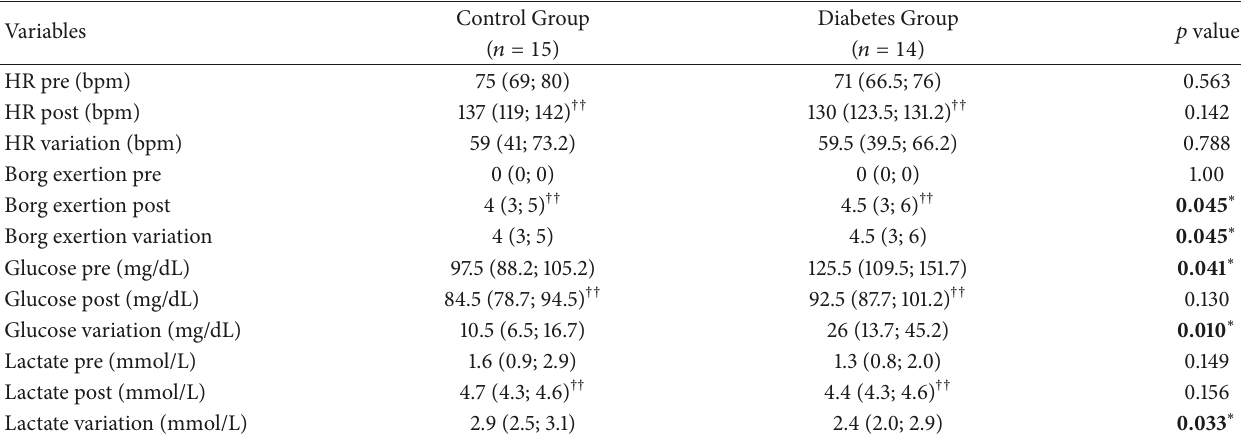
Table 2: Comparison between intra- and intergroups after